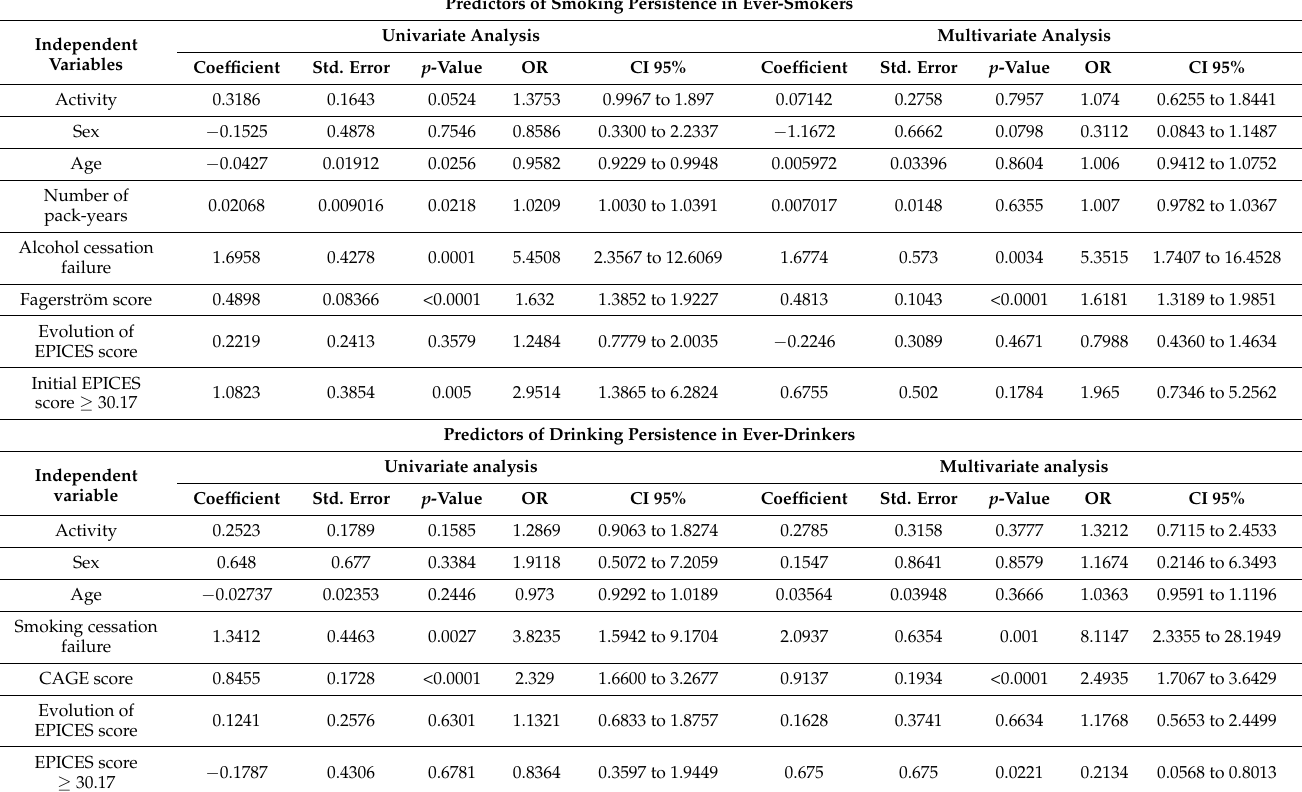
Table 6. Predictive analysis of determinants of persistent consumption in ever-smokers and ever-